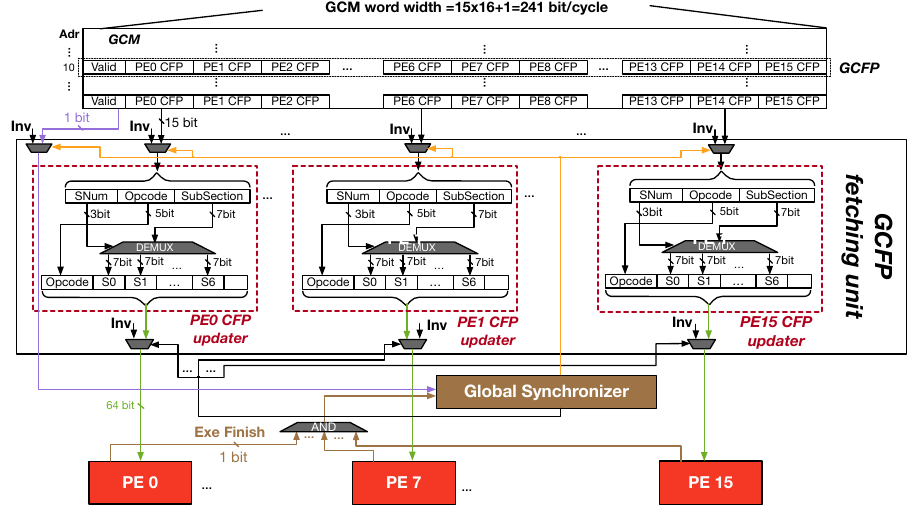
Figure 8. Architecture support for the centralized CFP-fetching